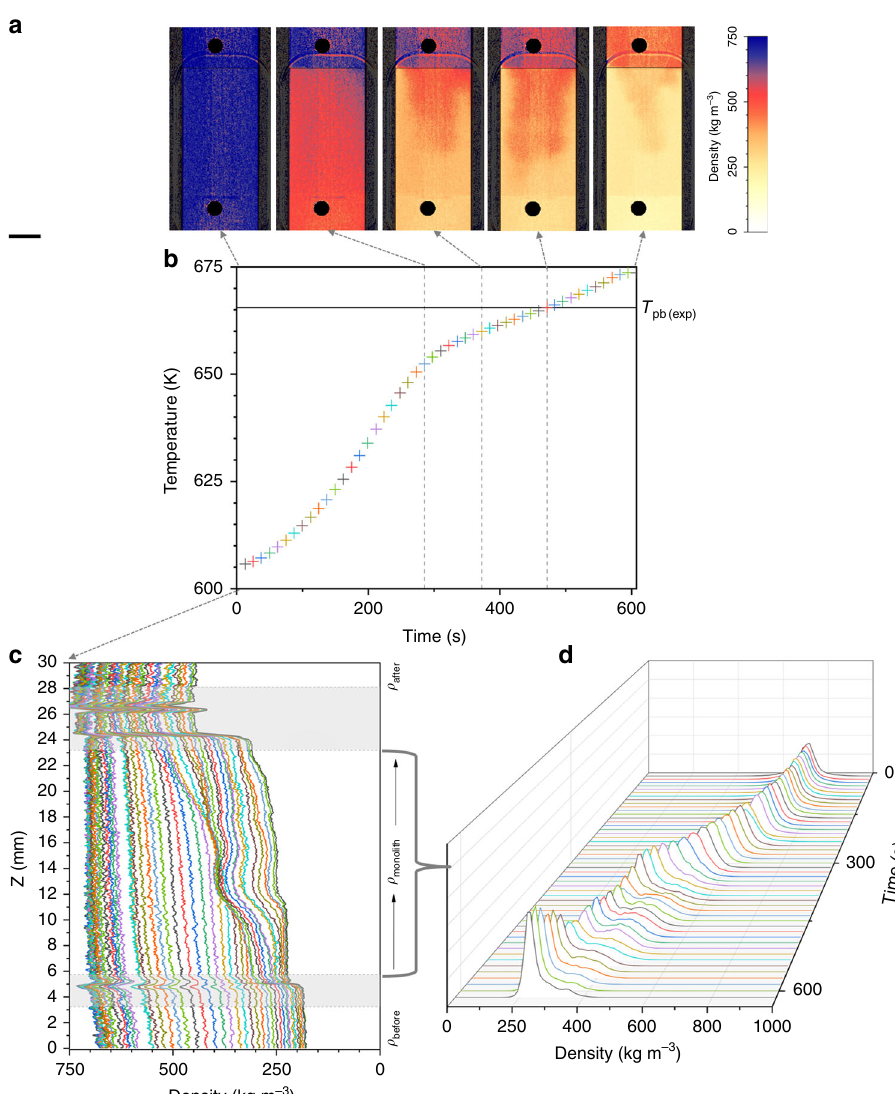
Fig. 5 Time evolution of the system during isobaric heating at 270 bar. a A set of representative color scaled density maps are presented to indicate a few signi fi cant moments: when the color changes from blue to red, then the coexistence of orange reddish with yellow, and then the conversion to pale yellow; the length of the scale bar is 5 mm. b The temperature pro fi le recorded before the monolith with the indication of the temperature of the plateau ( T pb(exp) ). c Vertical densities pro fi les and d densities histograms for the monolith region. Each point in the temperature pro fi le corresponds to a line in the density pro fi le and a density histogram. Source data for b – d are provided as a Source Data fi le